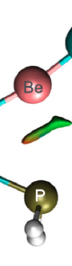
Figure 3. NCI plot for the PH 2 :BeCl structure showing the weak interaction between the donor and acceptor (green-colored isosurface) and a slightly red-colored region denoting a certain connection between the four atoms susceptible of forming a ring through a BeB.